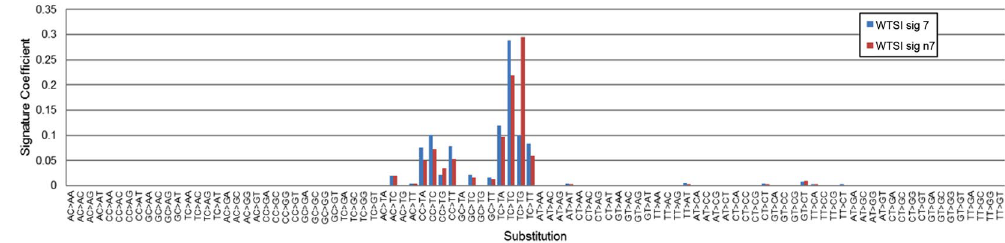
Figure 1. Normalizing trinucleotide frequencies. Figure 1 illustrates the effect of normalization of signatures. UV-associated WTSI signatures 7 and n7 are shown, with blue bars for the first of these signatures, normalized on the basis of the actual trinucleotide frequency of the whole human genome (Alexandrov et al . 3 , Supplementary Fig. S9a) and red bars for the second of these signatures, normalized according to an equal trinucleotide frequency representation (Alexandrov et al . 3 , Supplementary Fig. S9b). In the case of normalization according to an equal trinucleotide frequency representation, T[C > T]G mutations dominate, whereas in the case of normalization on the basis of the actual trinucleotide frequency of the whole human genome, T[C > T]C mutations